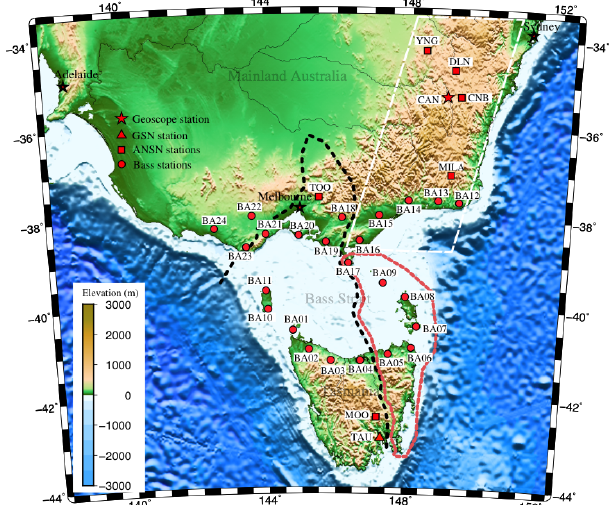
Figure 2. Location of seismic stations used in this study superim- posed on a topographic and bathymetric map of southeast Australia (modified from Bello et al., 2019a). The boundary of VanDieland is delineated by a thick black dashed line. The thick red dashed line outlines the boundary of the East Tasmania Terrane and Furneaux Islands. The thick white dashed line highlights the eastern sector of the Lachlan Fold Belt. The topography and bathymetry are based on the ETOPO1 dataset (Amante and Eakins,